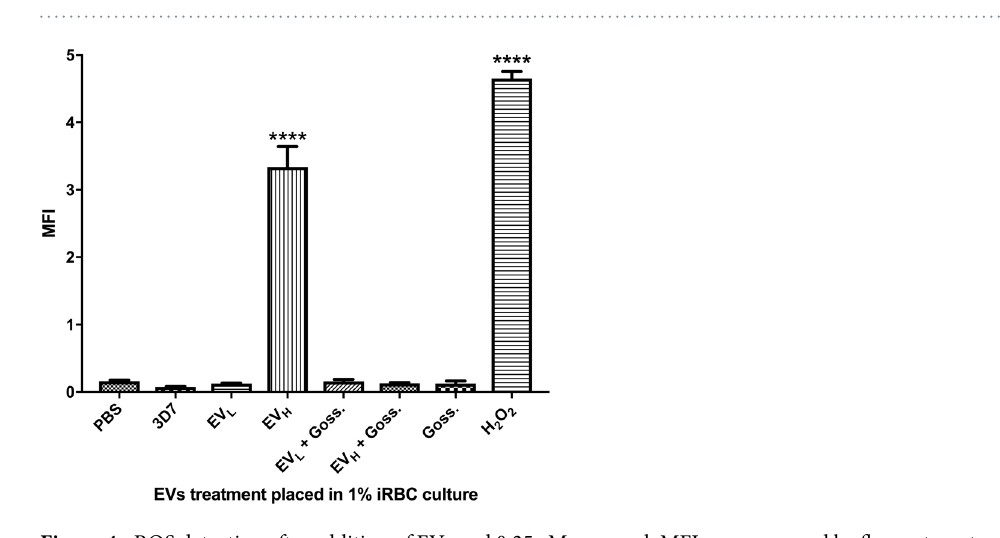
Figure 3. Inhibition of Pf LDH rescues the population regulation of EVs. Growth fold change was measured after distinct EV treatments and the addition of gossypol by flow cytometry. The average and S.D. of 3 replicas for each treatment is shown. (mean ± s.e.m.; n = 3 replicas), * P < 0.05 versus PBS control (Bonferroni’s test).